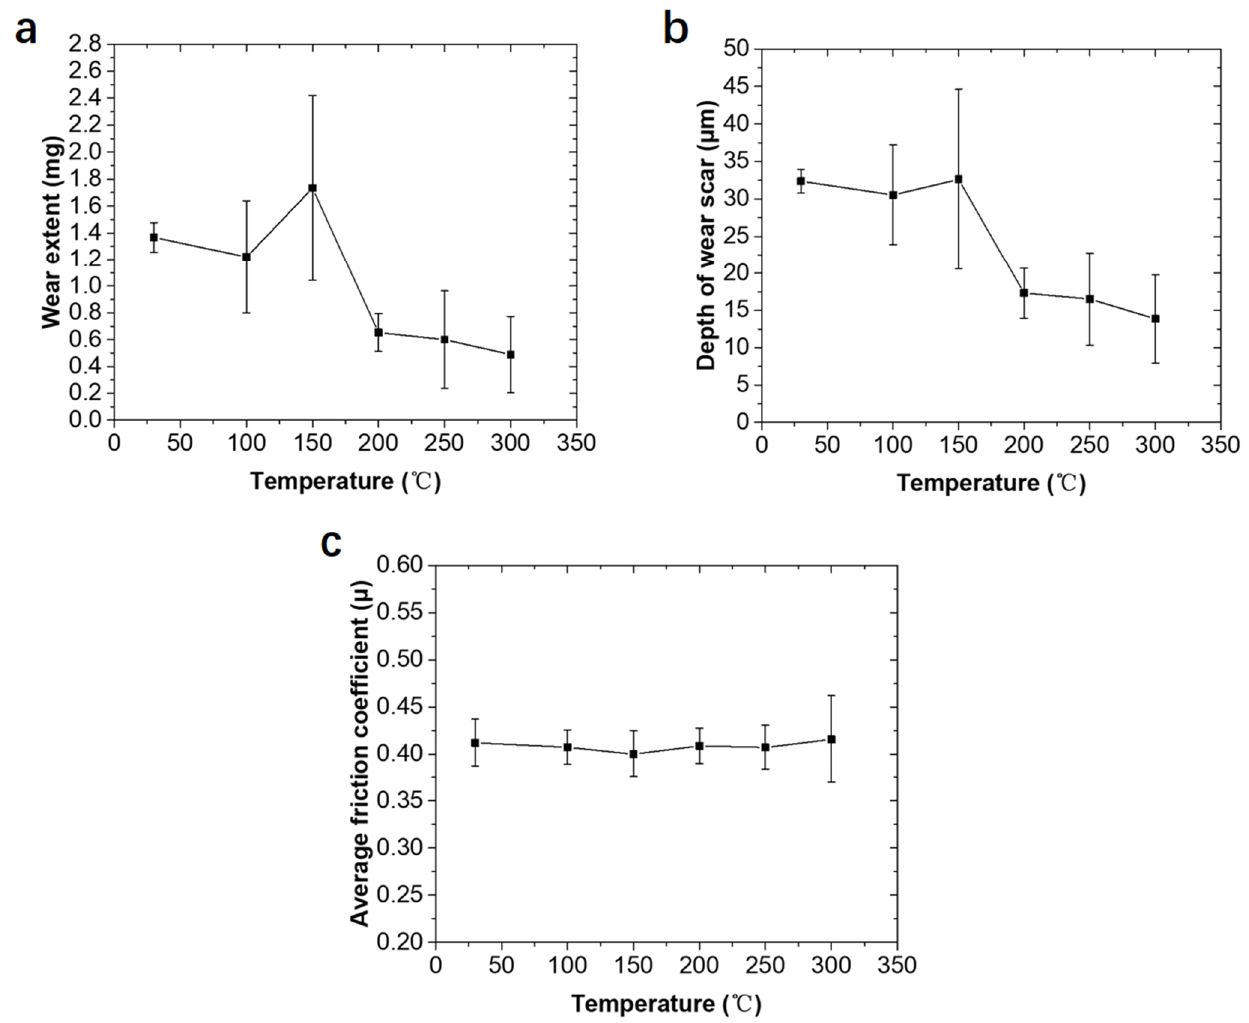
Figure 5. ( a ) Wear curves at 30 °C, 100 °C, 150 °C, 200 °C, 250 °C and 300 °C; ( b ) Wear scar depth curves at 30 °C, 100 °C, 150 °C, 200 °C, 250 °C and 300 °C; ( c ) Curves of the average friction coefficient at 30 °C, 100 °C, 150 °C, 200 °C, 250 °C and 300 °C. Figure 6 is a graph of the friction coefficient changing with time at various exper- imental temperatures. As shown in the figure, at each experimental temperature, the friction coefficient does not show large fluctuations with time, reflecting a stable friction